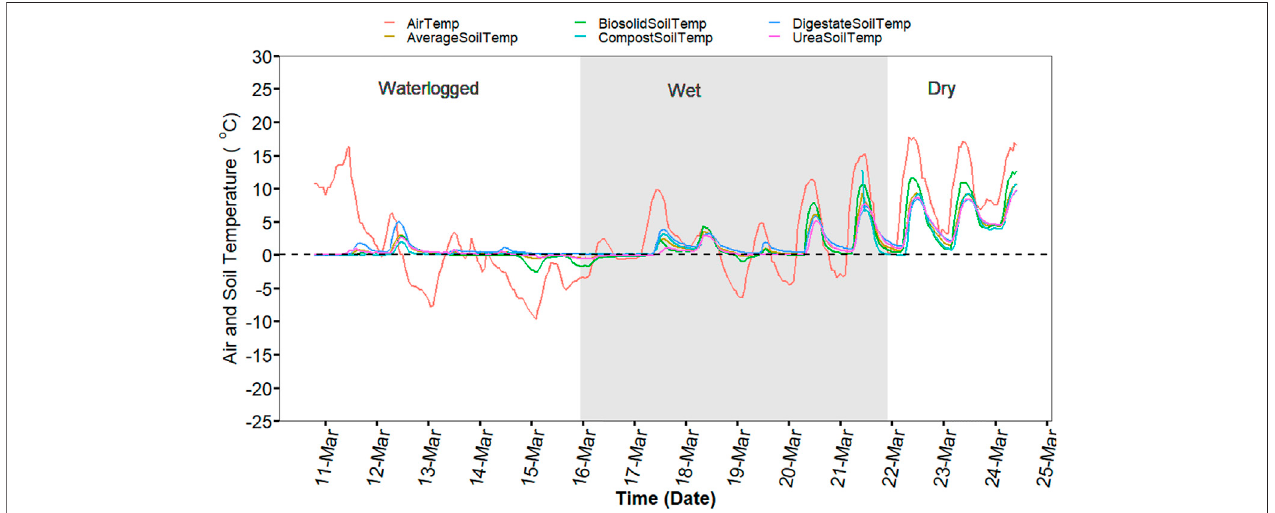
FIGURE 1 | Hourly soil temperature from the four treatment plots (~10 cm) and air temperature during the experiment period (from 11 March 2020 to 24 March 2021).